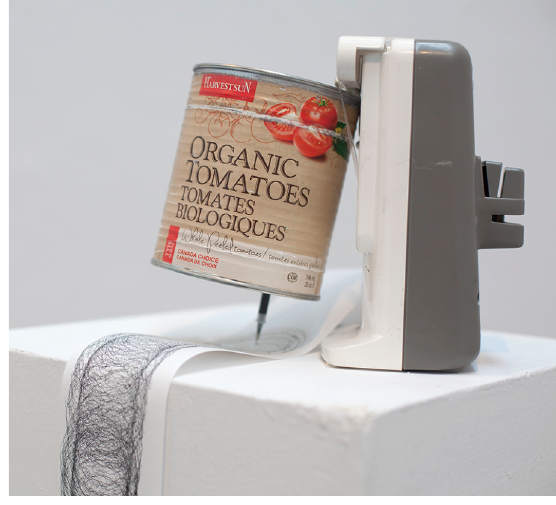
Figure 1 | The Opener. Drawing Machine.